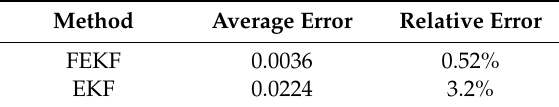
Table 3. Error comparison between FEKF and